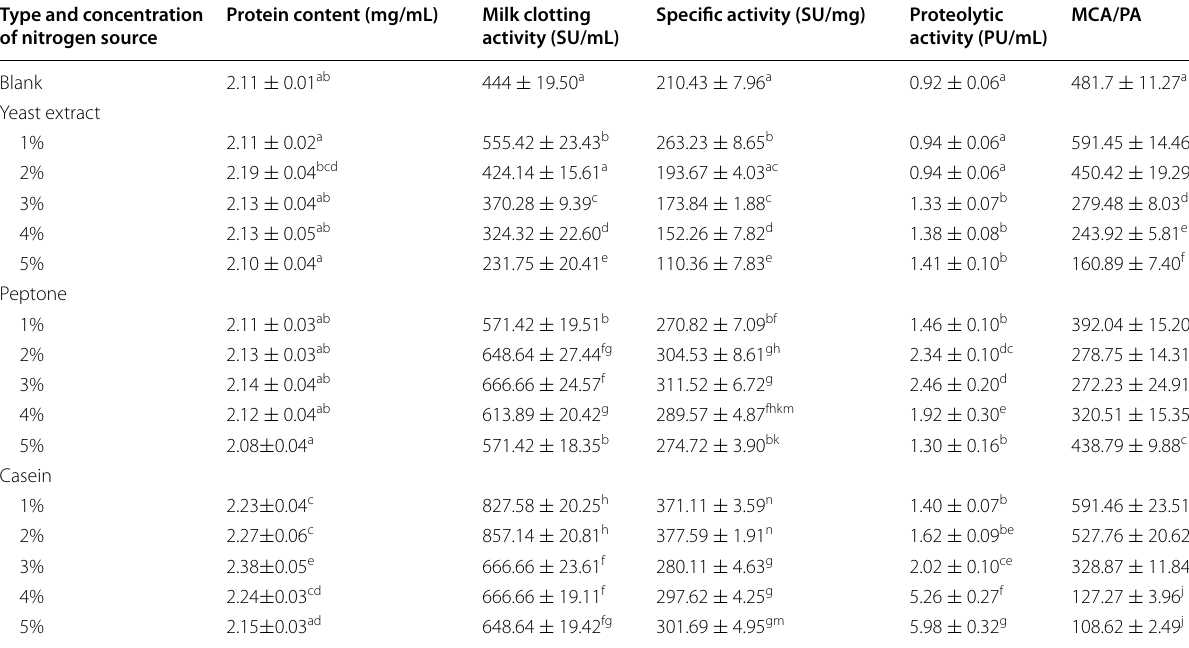
The results are expressed as mean SD. Within columns, values followed by the same letter(s) are not significantly different at the 0.01 level ±